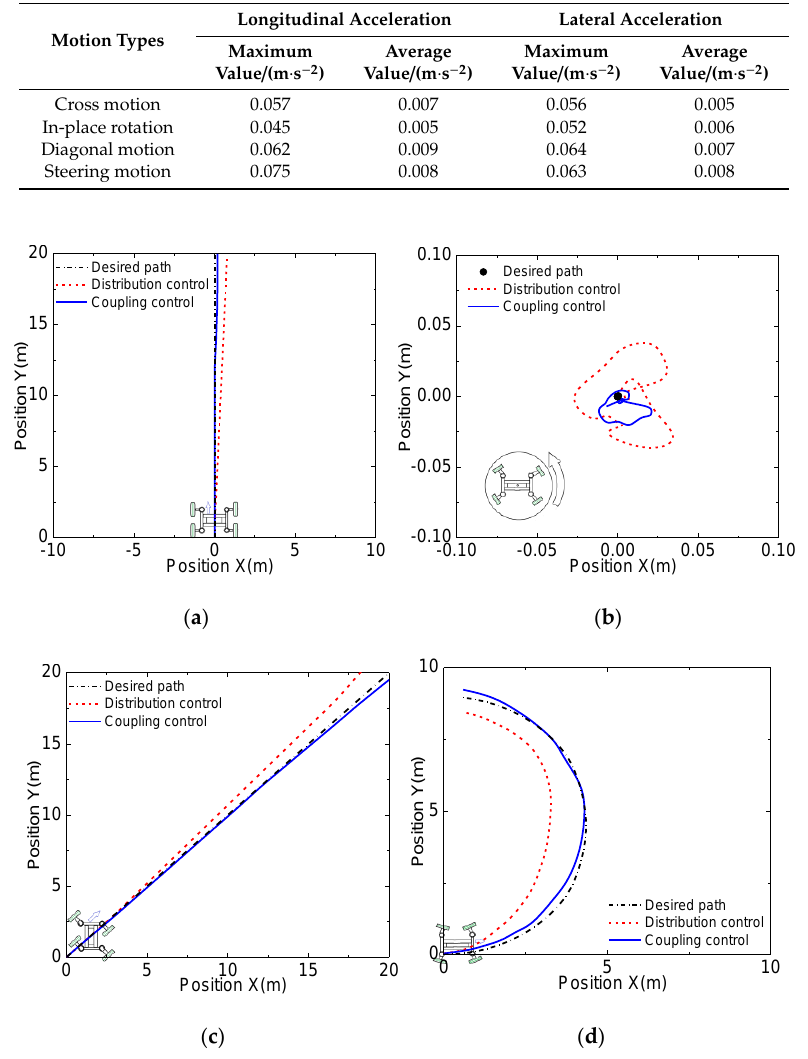
Figure 17. Trajectories under ( a ) cross motion; ( b ) in-place rotation; ( c ) diagonal motion; ( d ) steering motion.